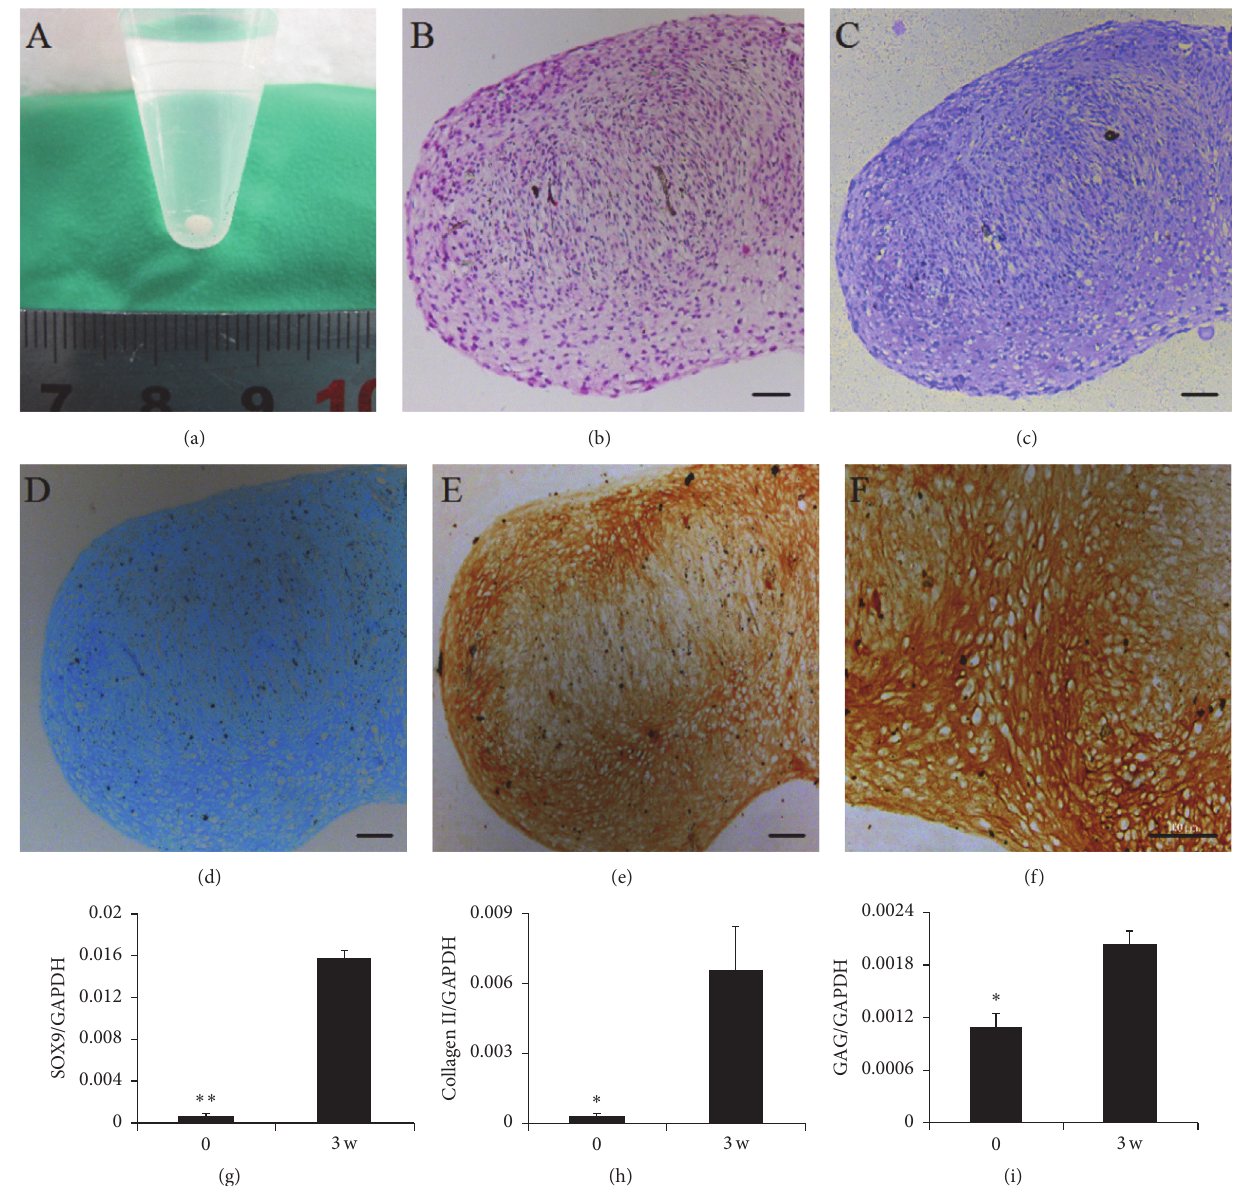
Figure 5: Chondrogenic differentiation potential of third-passage MSCs cultures derived from meniscal debris. At 21 day after chondrogenic induction, chondrogenesis was induced under serum-free micromass pellet culture conditions (a) and analyzed using hematoxylin and eosin staining (b) for general histology, Toluidine Blue (c) and Alcian Blue staining (d) for GAG, and immunohistochemical staining for type II collagen in chondrogenic matrix ((e): low-magnification; (f): high-magnification). Scale bar = 100 𝜇 m. Expression of chondrogenic genes SOX9 (g), type II collagen (h), and GAG (i) was assessed by real-time PCR. Data are presented as mean ± SD. ∗ 𝑃 < .05 ; ∗∗ 𝑃 < .01